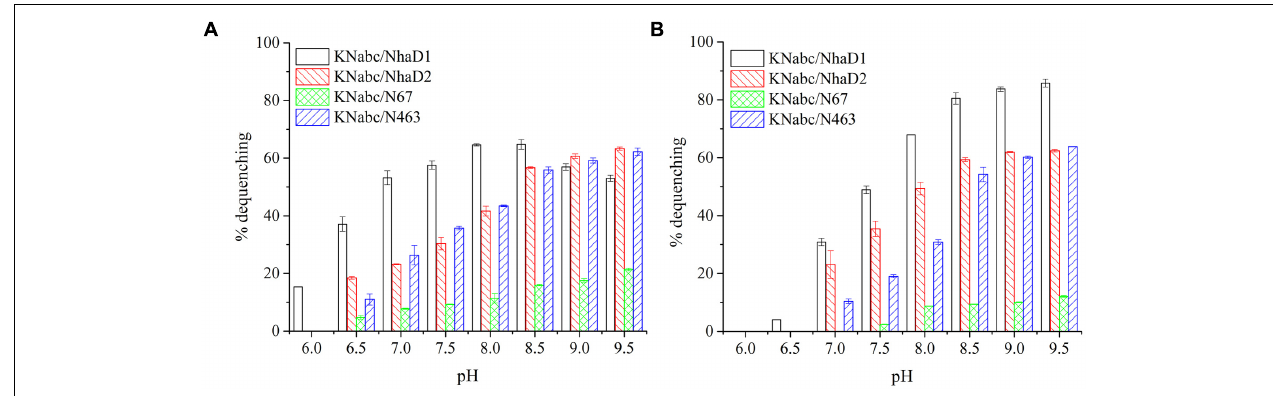
FIGURE 5 | Fluorescence-based antiport activities of NhaD2 chimerical proteins in sub-bacterial vesicles. (A) Transport activities of NhaD2 chimeric proteins with a supplementation of 10 mM NaCl at various pHs. (B) Transport activities of NhaD2 chimeric proteins with a supplementation of 10 mM LiCl at various pHs.